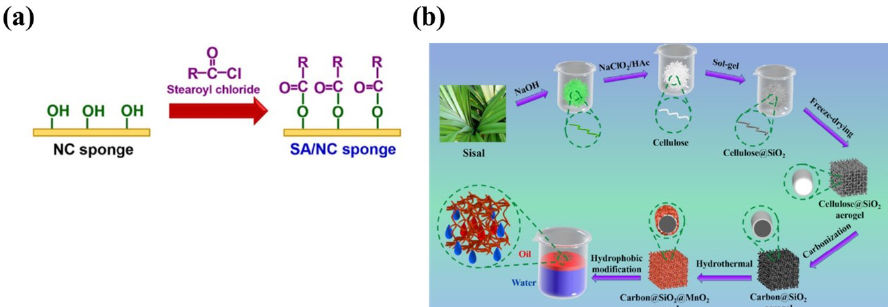
Figure 6. ( a ) Schematic of surface modification on NC sponge by stearoyl chloride (R-C 17 H 35 ). Re- produced with permission [36]. Copyright 2018, Elsevier Ltd. ( b ) Schematic illustration of fabrication of the modified HBCSM aerogel. Reproduced with permission [115]. Copyright 2019, American Chemical